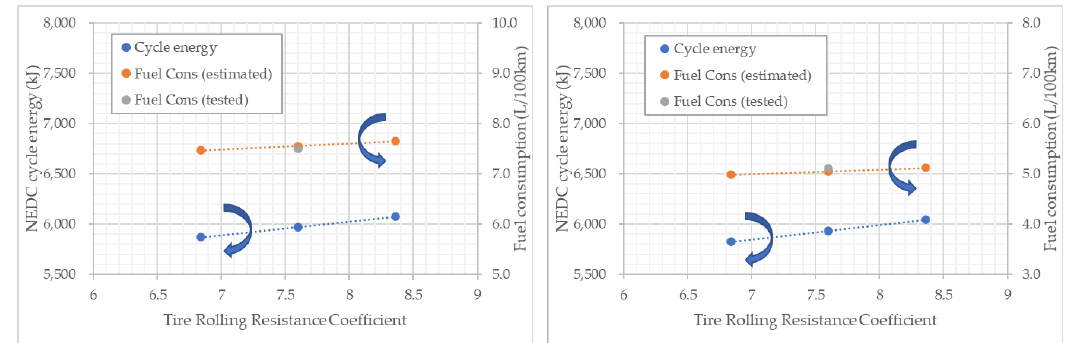
Figure 19. Effect of the tire rolling resistance on the cycle energy and fuel consumption in NEDC (left/right: gasoline/diesel) .